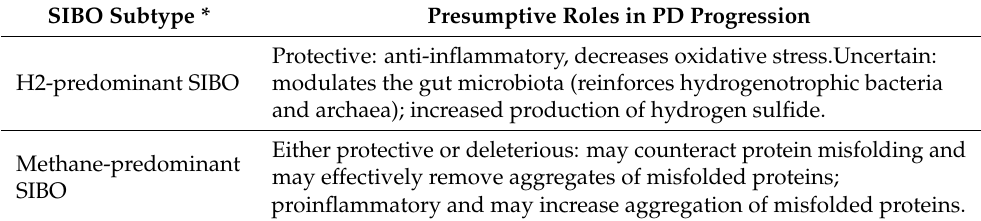
Table 2. Possible roles of SIBO subtype in PD